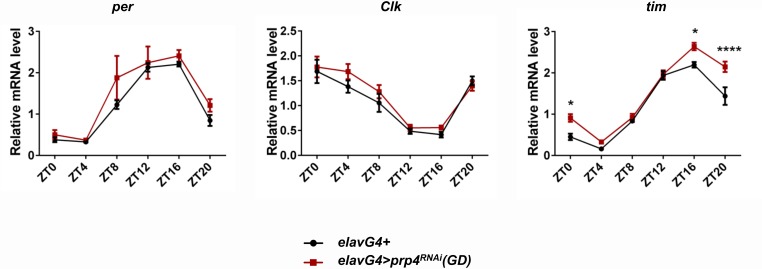
Pan-neuronal knockdown of prp4 increases tim expression.per and Clk expression is unchanged while tim expression is increased at night (ZT16-ZT0) in the heads of flies with pan-neuronal prp4 downregulation (elavGal4; Dcr2 > prp4RNAi(GD)) as compared to control (elavGal4; Dcr2/+); p* ≤ 0.05, p**** ≤ 0.001 by by two-way ANOVA and Sidak’s post hoc test.Three independent qPCR experiments were performed in triplicates, normalized to rp49 and analyzed using the ∆∆Ct method. Error bars = SEM.